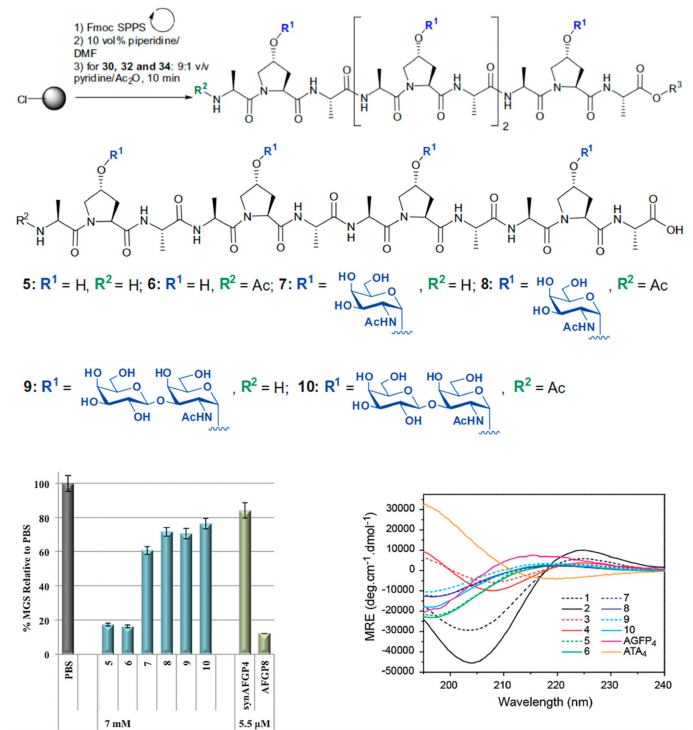
Figure 9. Synthesis scheme of polyproline based antifreeze peptides. PPII structures are built by synthesizing and modifying peptides containing high amounts of prolines in the sequence. The amino group of prolines can be further functionalized to accommodate moieties such as carbohydrates. PPII structures were confirmed by CD spectroscopy. Reprinted with permission from Bioorg. Med. Chem. 2013 , 21 , 3569–3581